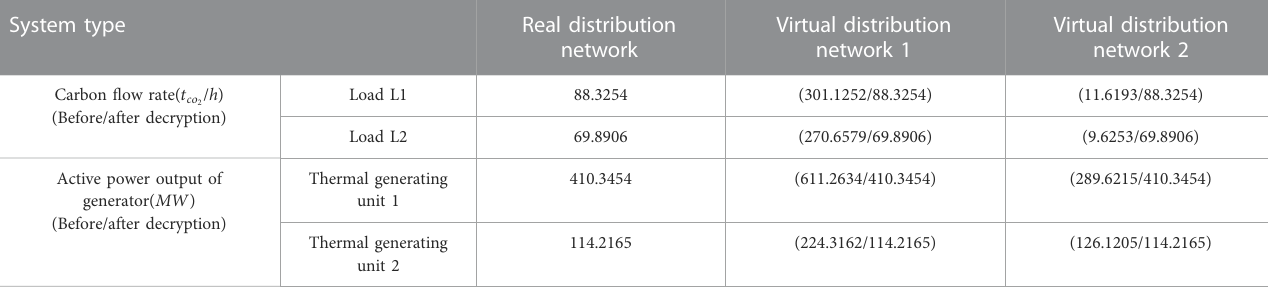
TABLE 1 Comparison of calculation results between real and virtual